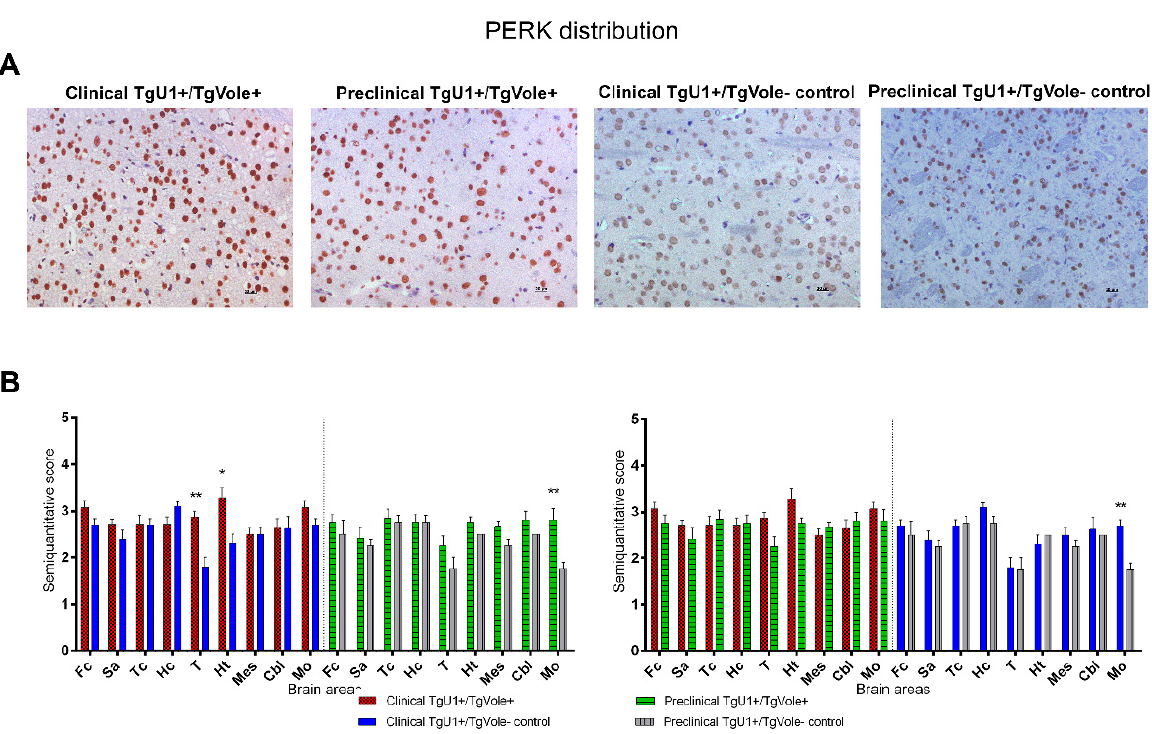
Figure 1. PRKR-like endoplasmic reticulum kinase (PERK) upregulation in the thalamic area of clinical TgU1 + /TgVole + mice. ( A ) Nuclear staining was observed for PERK in numerous cells of all groups of mice. The number of immunopositive cells was higher and immunostaining was stronger in TgU1 + /TgVole + mice, especially in the thalamus and hypothalamus. Images correspond to the hypothalamic area in all mice. ( B ) PERK distribution in the brains of clinical and preclinical TgU1 + /TgVole + mice and their age-matched controls. PERK immunostaining was analyzed using a semiquantitative scale from 0 (lack of immunostaining) to 5 (very intense immunostaining) in nine different brain areas: frontal cortex (Fc), septal area (Sa), cortex at the level of the thalamus (Tc), hippocampus (Hc), thalamus (T), hypothalamus (Ht), mesencephalon (Mes), cerebellum (Cbl) and medulla oblongata (Mo). The number of animals studied was the following: clinical TgU1 + /TgVole + n = 6 (4 female, 2 male), clinical TgU1 + /TgVole − controls n = 8 (6 female, 2 male), preclinical TgU1 + /TgVole + n = 5 (2 female, 3 male) and preclinical TgU1 + /TgVole − controls n = 5 (2 female, 3 male). Comparison of the PERK immunolabeling revealed significant differences between clinical TgU1 + /TgVole + mice and clinical TgU1 + /TgVole − controls and between preclinical TgU1 + /TgVole + mice and preclinical TgU1 + /TgVole − controls in different brain areas. (* p < 0.05, ** p < 0.01, Mann-Whitney U